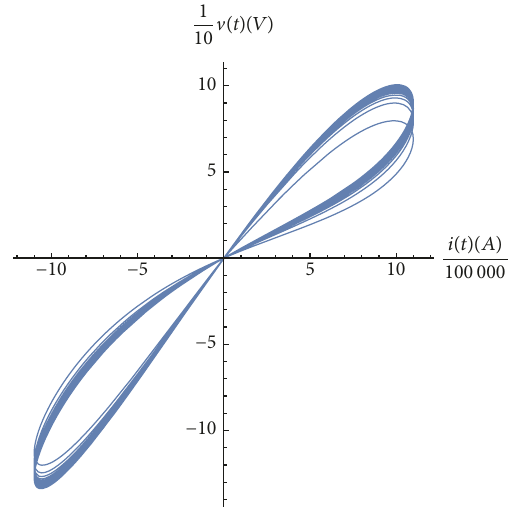
Figure 8: V (𝑡) - 𝑖(𝑡) of the fractional order memristor: 𝛼 = 0.75 and 𝐼 > 0. 𝑚